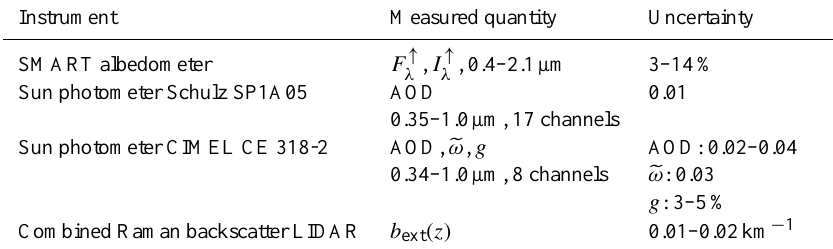
Table 1. Table of airborne and ground-based measurements in Zhongshan, China, 2009.